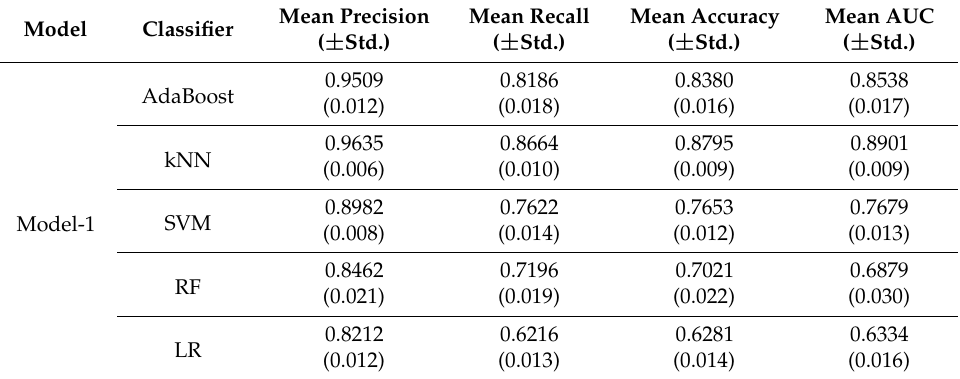
Table 5. Validation results of classifiers using stratified 10-fold cross-validation when data samples from the 15 recent HD sessions were